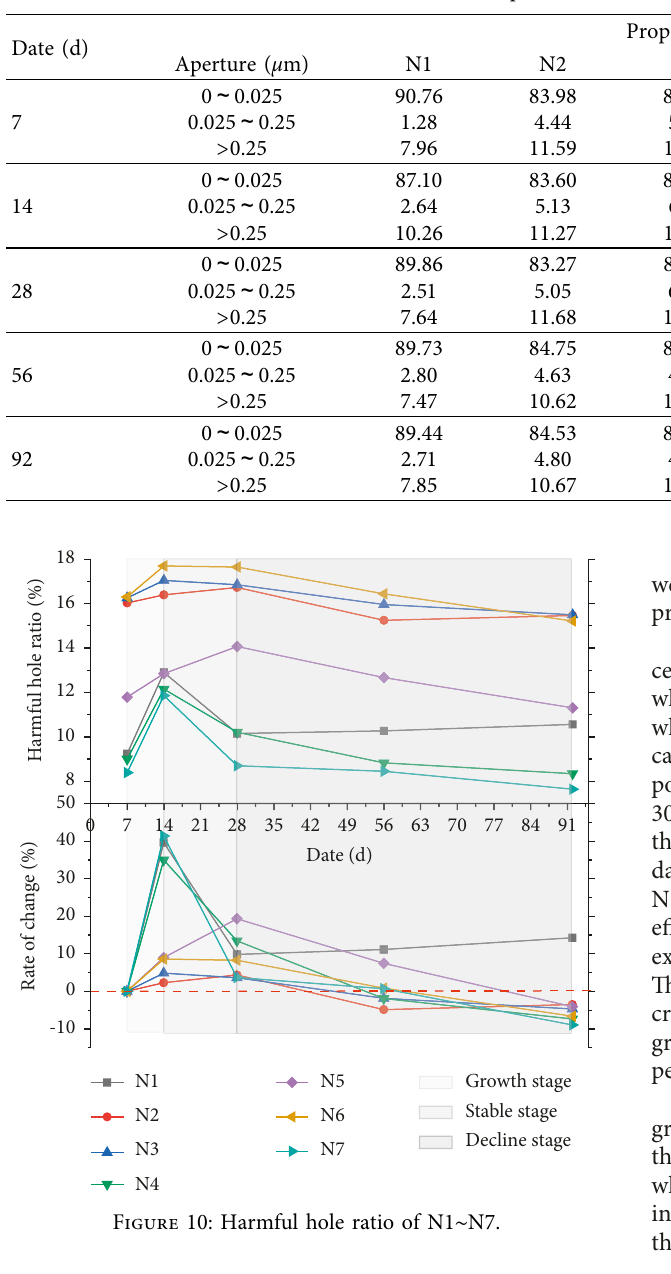
Table 6: The ratio of pores with different volume according to NMR.